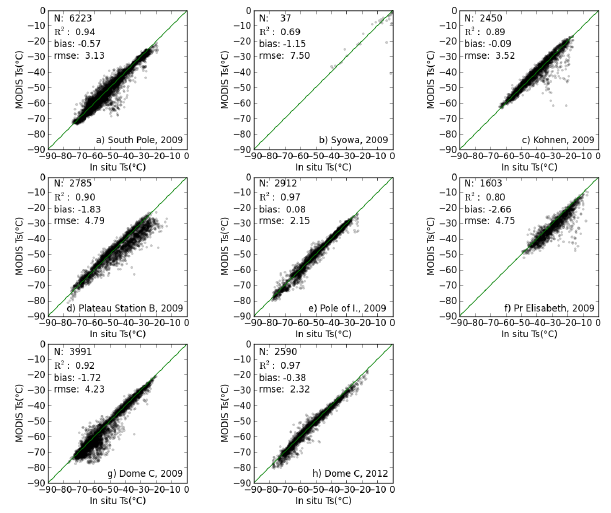
Figure 2. Comparisons of MODIS T s and in situ T s at (a) South Pole, (b) Syowa, (c) Kohnen base (AWS9), (d) Plateau Station B (AWS12), (e) Pole of Inaccessibility (AWS13), (f) Princess Elisa- beth station (AWS16), (g) Dome C in 2009 and (h) Dome C in 2012. “Pole of I.” means Pole of Inaccessibility and “Pr Elisabeth” means Princess Elisabeth. The number N of simultaneous MODIS T s and in situ T s used in the evaluation primarily depends upon satellite overpasses and cloudiness. In AWS stations, N also depends upon the filter used to select data not affected by riming. The green line represents the 1:1